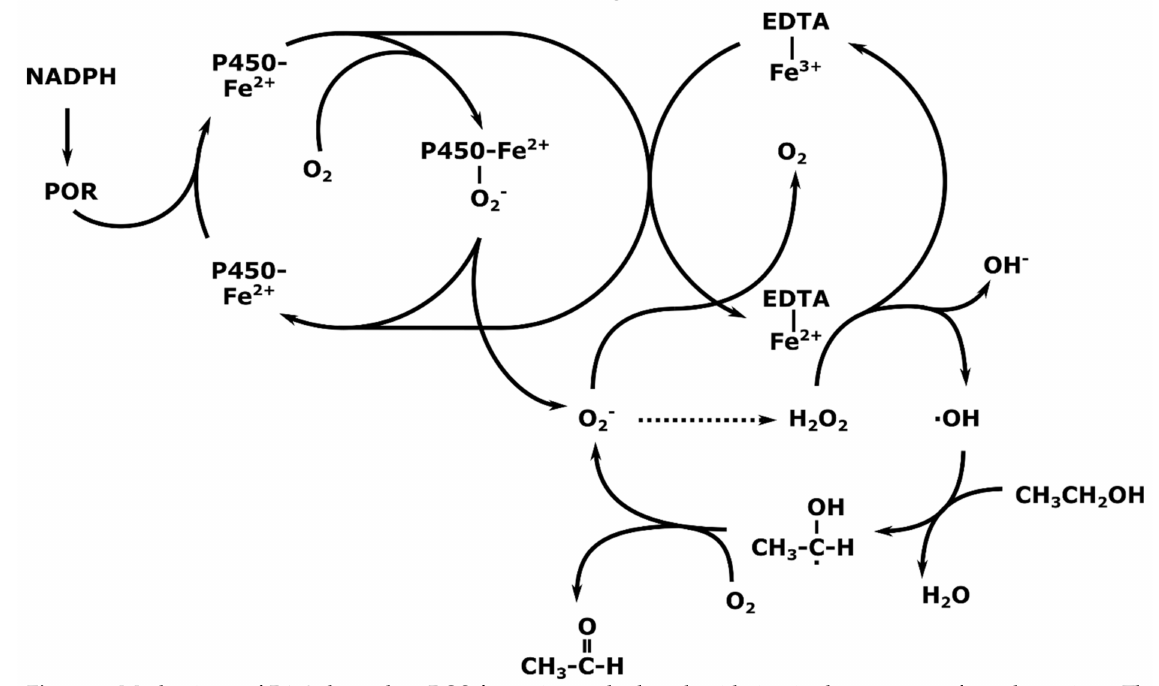
Figure 2. Mechanisms of P450-dependent ROS formation and ethanol oxidation in the presence of non-heme iron. The generated superoxide is dismutated to hydrogen peroxide (dashed arrow), which is cleaved in the presence of non-heme iron (Fe 2+ ) yielding hydroxyl radicals. These can extract the hydrogen on the α -carbon of ethanol creating a radical of ethanol which is spontaneously converted to acetaldehyde. Non-heme iron chelated to EDTA enhances the cleavage of hydrogen peroxide yielding the reactive hydroxyl radical. Basic mechanism as described in [54]. POR-P450